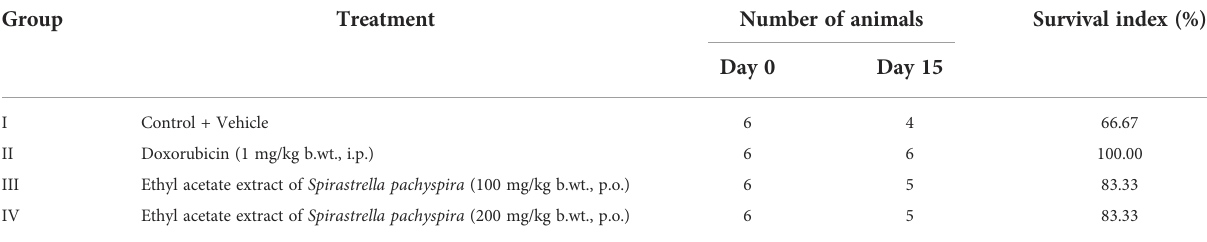
TABLE 3 The effect of ethyl acetate extract of Spirastrella pachyspira on the survival index of athymic mice bearing s.c. SK-BR-3 tumor.